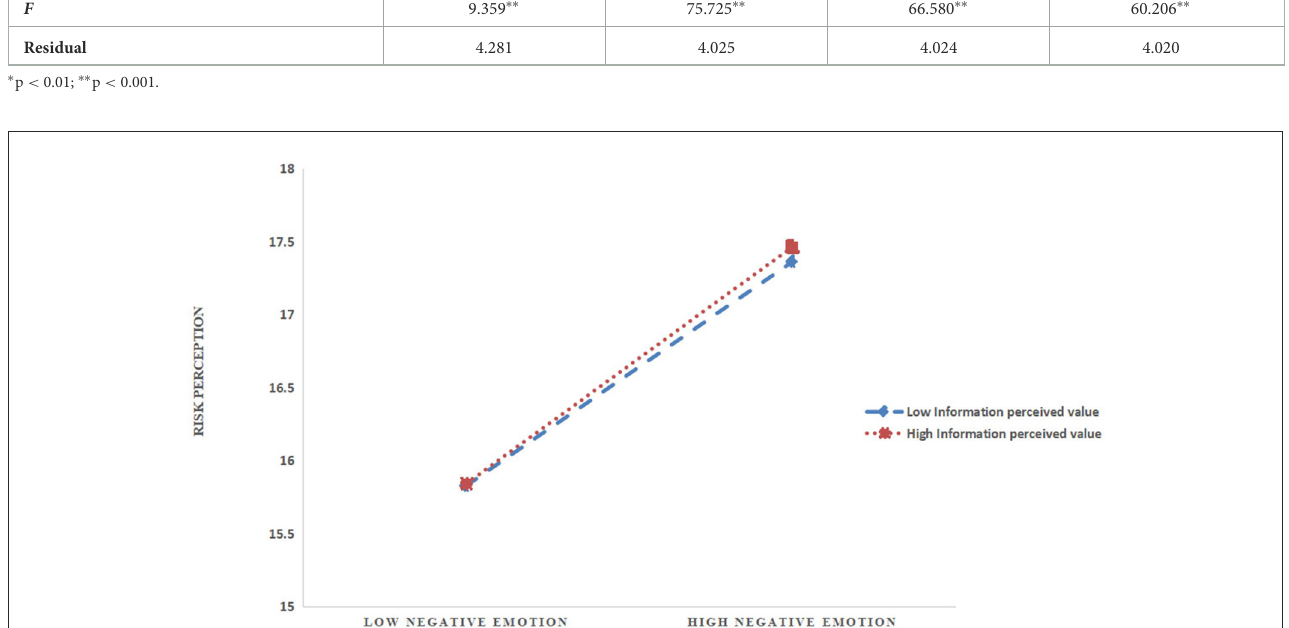
FIGURE3 Interactive effects of information perceived value and negative emotion on risk